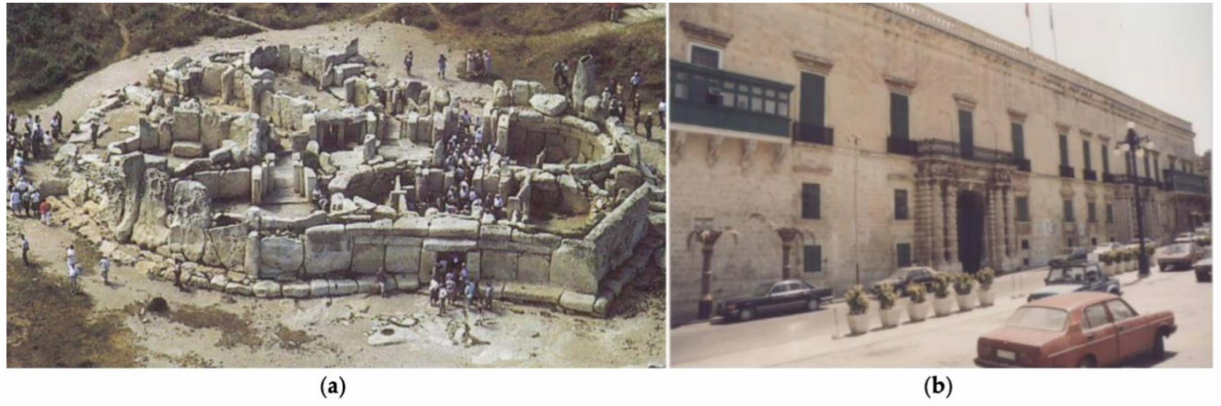
Figure 2. Dated photo of: ( a )